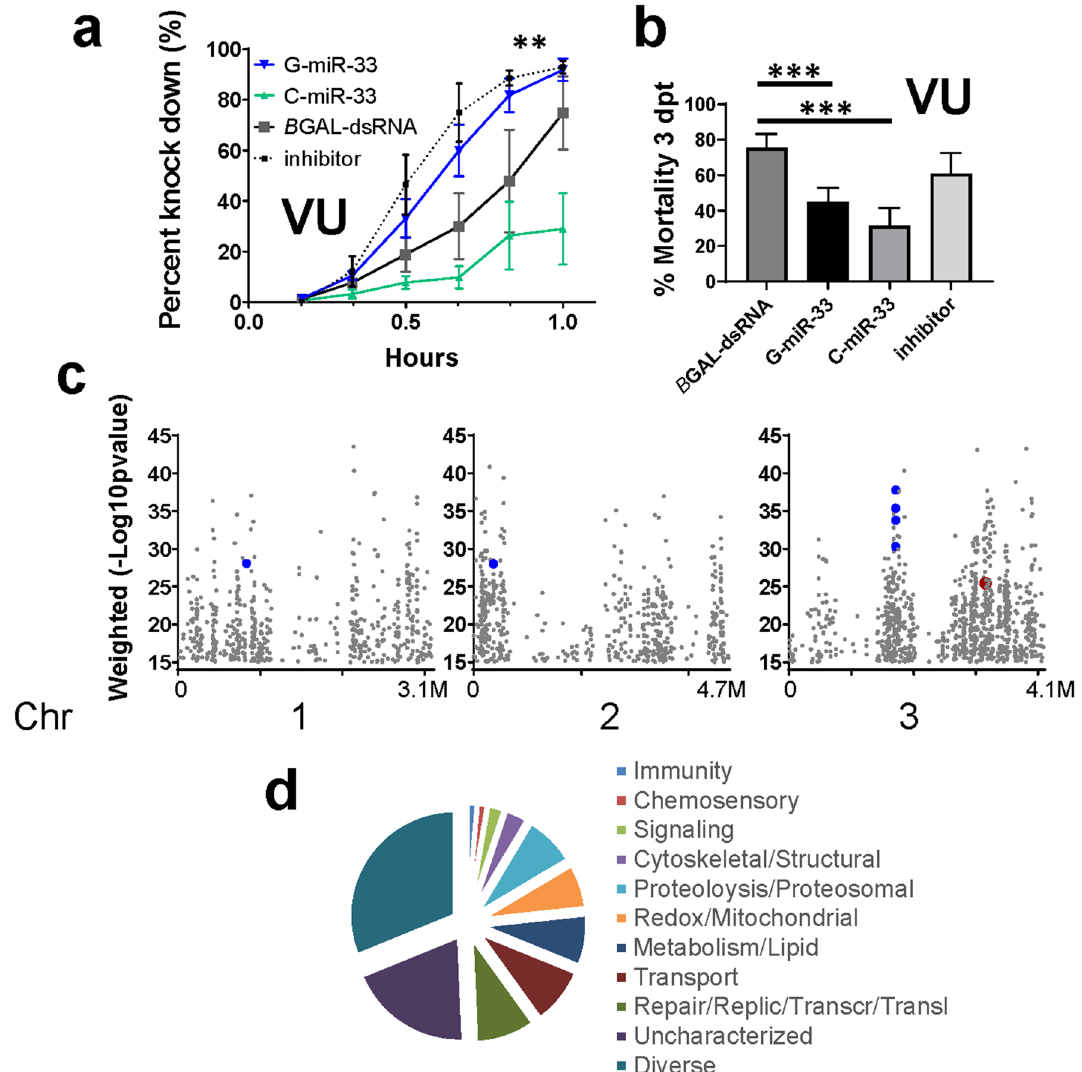
Figure 4. VU permethrin toxicological response in the presence of excess miR-33 isoforms and VR vs VU strain genetic association data. ( a ) MiR-33 pre-miRNA over-expression affects permethrin toxicological response (knockdown) in VU. G-pre-miR-33 or C-pre-miR-33 were over-expressed in VU (Vergel-unselected) adult mosquitoes, or depleted with inhibitor, followed by standard bottle assays using a discriminating permethrin dose (1.5 µg per bottle) (ANOVA **p = 0.0042). ( b ) Mortality of individuals from treatment in ( a ) at 3 days post permethrin exposure (Fisher’s Exact test, G-***p = 0.0002 and C-***p = 1.0 × 10 –5 ). ( c ) Genetic association analysis of target-capture gDNA deep sequencing shows genes arranged according to physical location along chromosomes. VGSC, − log 10 ( χ 2 p value) 25.43 indicated in red, CYPs with scores higher than VGSC are highlighted in blue and enlarged for emphasis (Supplementary Table S3). ( d ) Two hundred ninety two genes with − log 10 ( χ 2 p value) higher than VGSC were categorized according to predicted functional groups. Functional categories are indicated clockwise from top. Immunity 1.3%, Chemosensory 1.3%, Signaling 2.4%, Cytoskeletal/Structural 3.4%, Proteolysis/Proteosomal 7.9%, Redox/Mitochondrial 6.9%, Metabolism/Lipid 7.9%, Transport 8.9%, Repair/DNA Replication/Transcription/Translation (RRTT) 9.3%, Uncharacterized 19.5%, Diverse 31.1% (Prism GraphPad version 8.0., https:// www. graph pad. com/ scien tific- softw are/ χ 2 analysis. The − log χ 2 p value) was calculated at each SNP site, and final gene-wise weighted averages were 10 ( determined (see “Methods”). Genes with weighted average − log 10 ( χ 2 p value) ≥ 15 (n = 2112) were identified, one of which was a long non-coding RNA (AAEL026905, location chr 3: 348,887,920–348,889,837). Five hundred forty nine, 573 and 990 association genes were located on chromosomes (chr) 1, 2 and 3, respectively (Fig. 4c). Overall, the gene set comprised multiple predicted functional categories, from transport to signal transduction and metabolism to cytoskeleton/structural (Supplementary Table S3). In our previous study, we identified genes with predicted asso- ciations with motoneuronal function 26 , including the permethrin target, VGSC. In the current work, twenty-three neuronal-associated genes, including VSGC, were present in the highlighted gene set (Fig. 4c, Supplementary